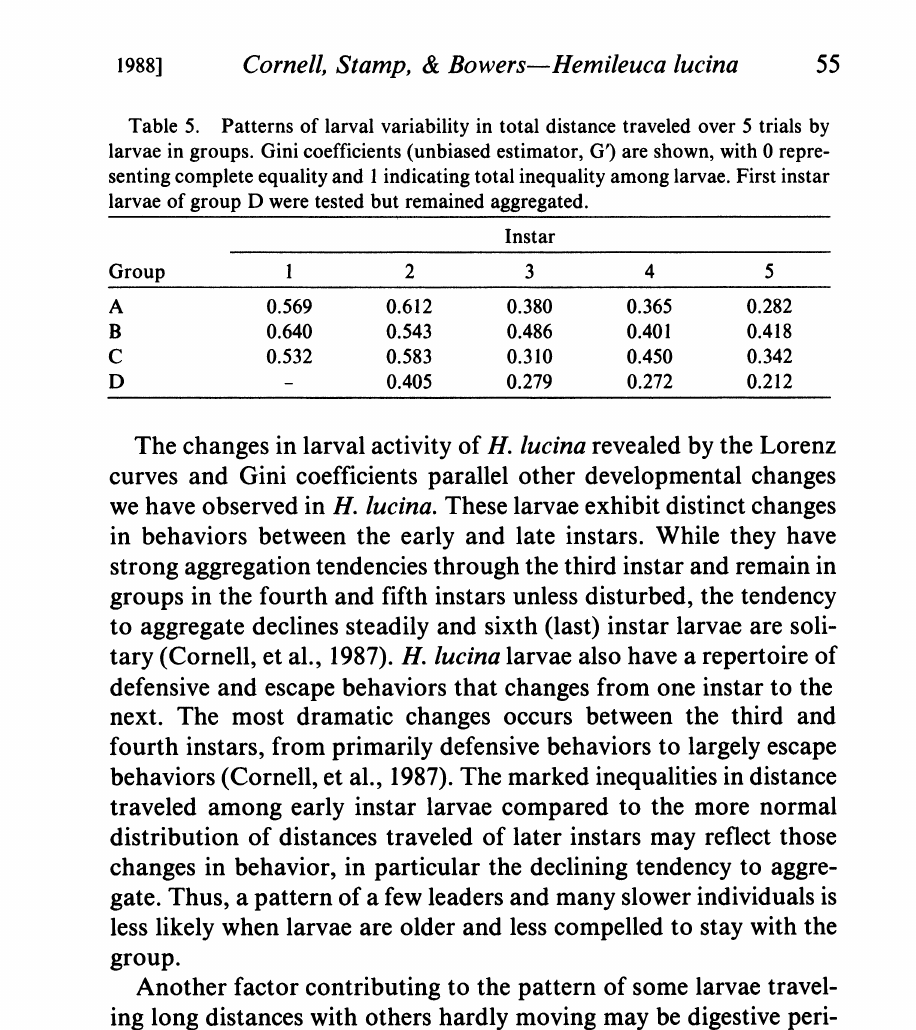
Table 5. Patterns of larval variability in total distance traveled over 5 trials by larvae in groups. Gini coefficients (unbiased estimator, G’) are shown, with 0 repre- senting complete equality and indicating total inequality among larvae. First instar larvae of group D were tested but remained